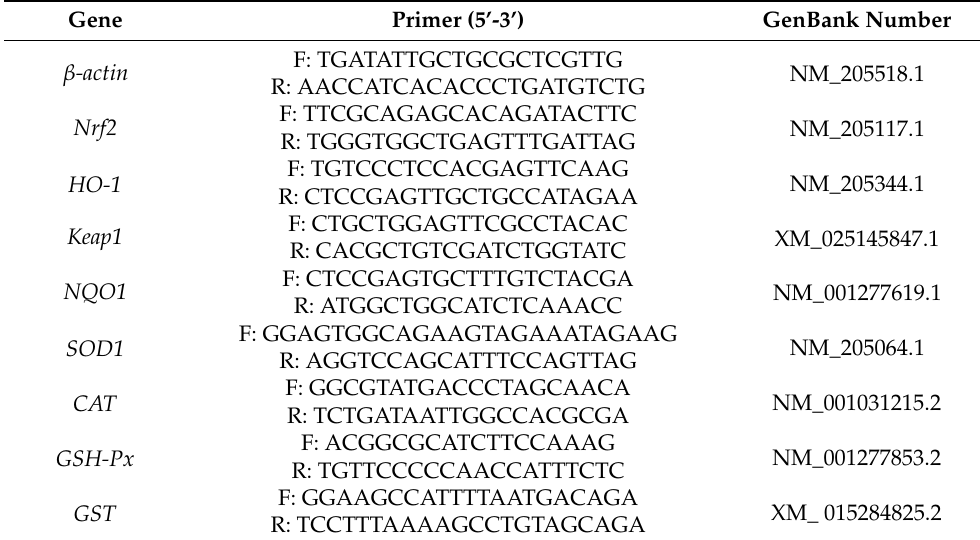
Table 2. Sequences of the primers used for the detection of gene expression